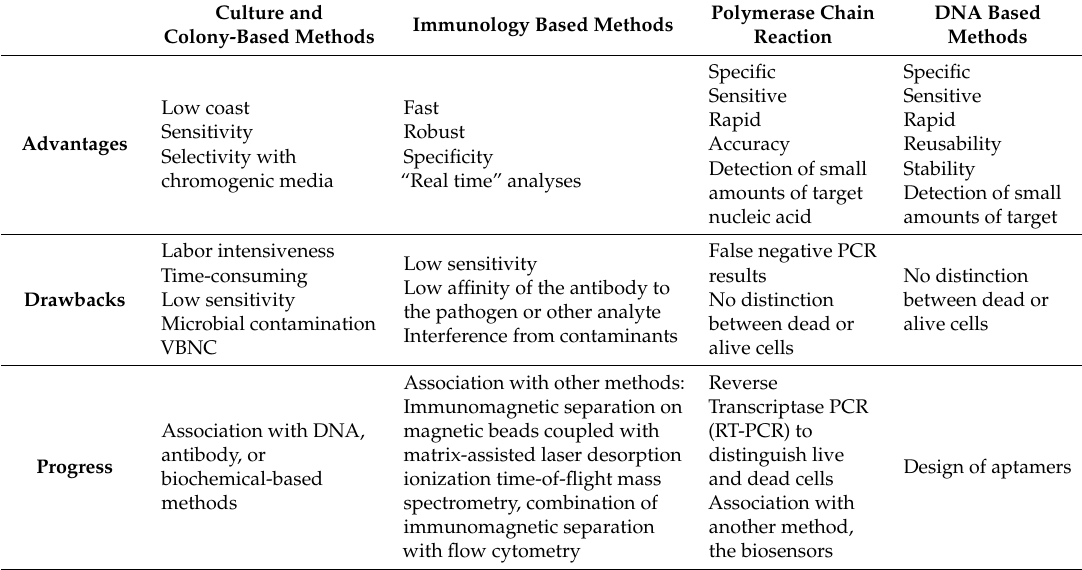
Figure 2. International standard NF EN ISO 6579. This international standard is a horizontal method used for the detection of Salmonella , including S . Typhi and S . Paratyphi, in products intended for human consumption or animal feed and in environmental samples in the area of production and handling of food. Table 1. Advantages and drawbacks of the conventional methods used for the detection of Salmonella in